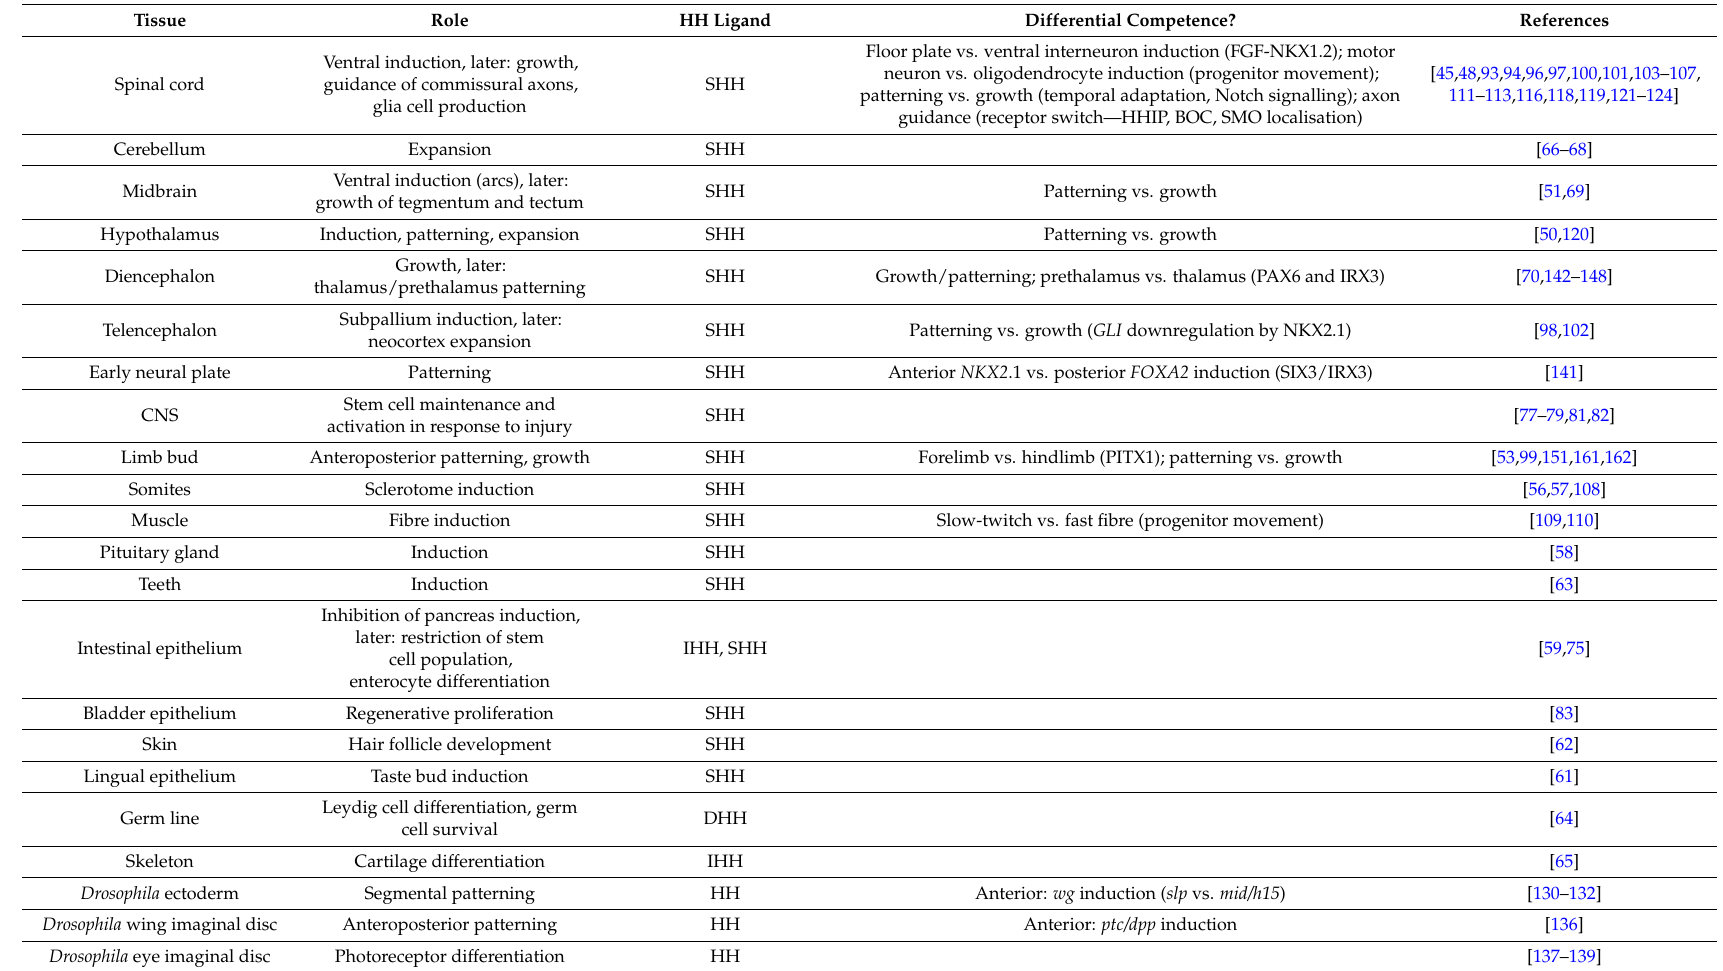
Table 1. Different roles of Hedgehog (HH) signalling discussed in this